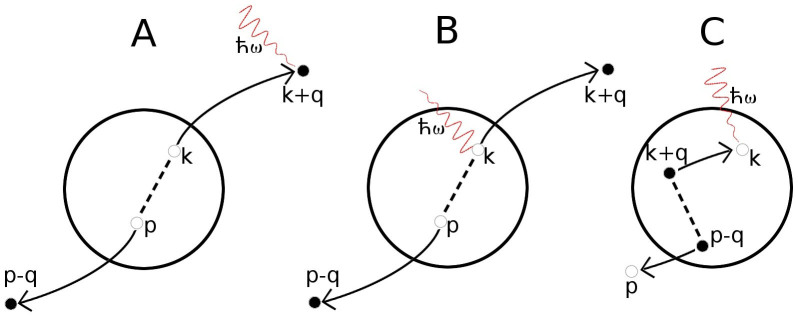
Physical scattering processes described by the perturbative corrections to the Brueckner-Goldstone response function Sk(δ).See main text. Diagram A describes a process in which two particles with momenta + and − are scattered to momenta k and p and the radio-frequency photon of energy  flips the spin-state of the momentum k atom. Diagram B describes a shadow process of diagram A, in which the atoms scatter away from states k and p, leaving holes in place. Finally, the diagram C describes a process in which the rf-photon first excites an atom with momentum k, leaving thus a hole in the sea of |↑〉-atoms. This is followed by the scattering of two atoms with momenta + and − into the hole in k and some empty state p.